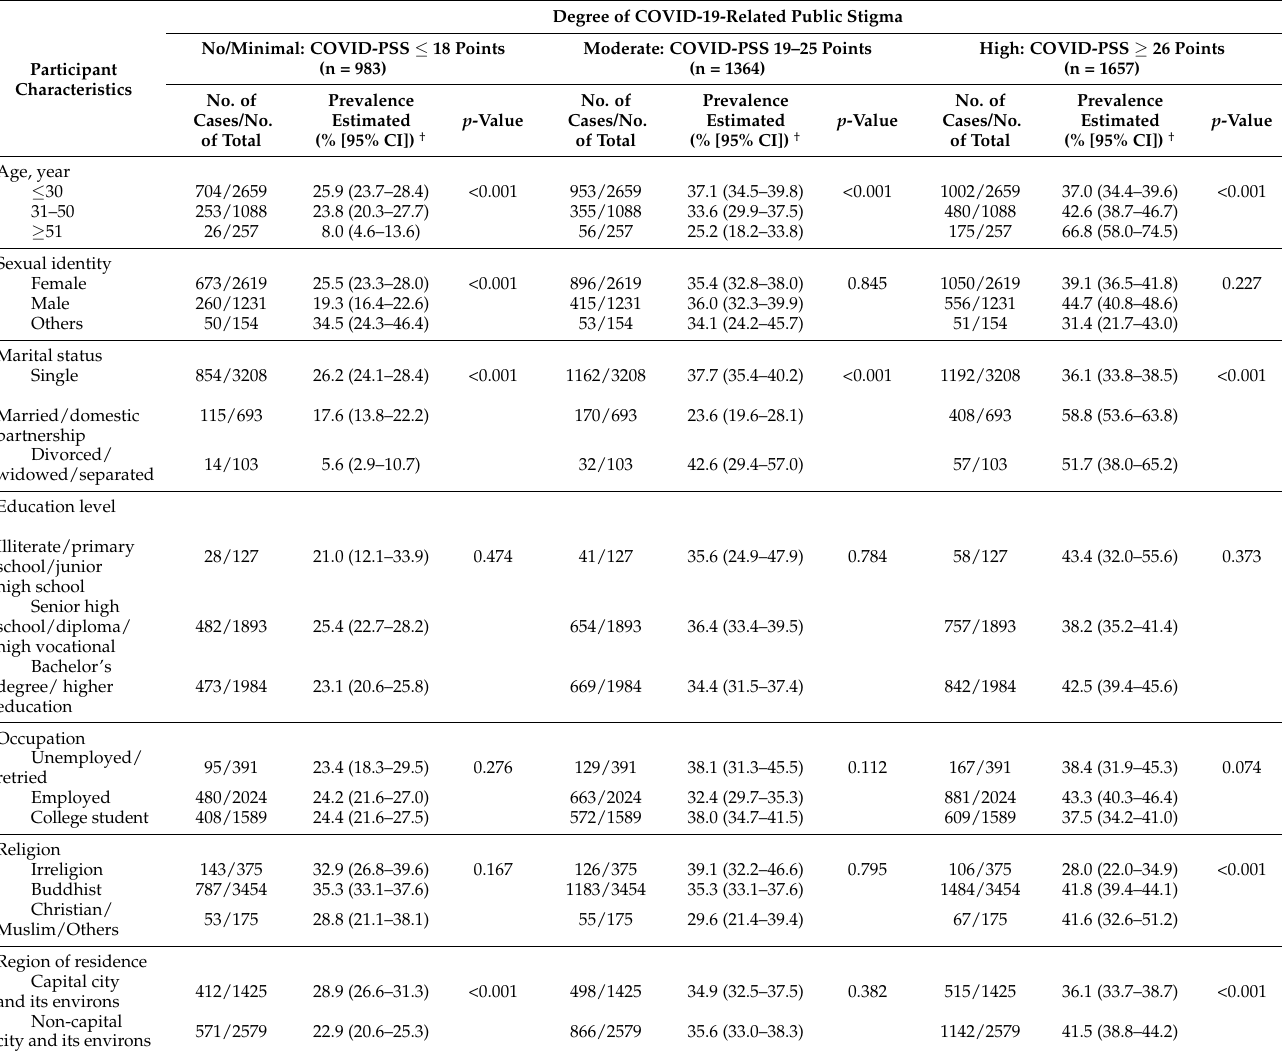
Table 1. Prevalence of COVID-19-related public stigma among general population in